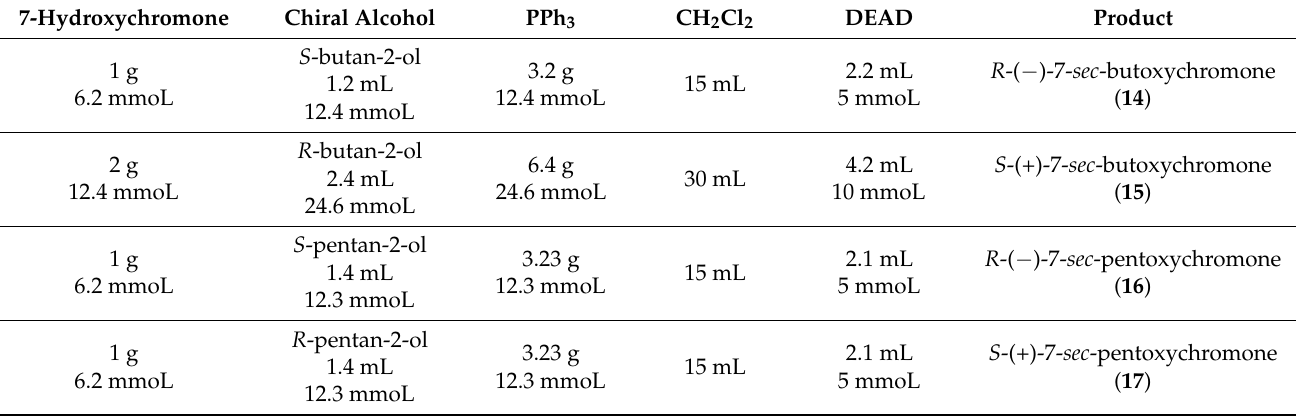
Table 2. Conditions of the synthesis of R -( − )-7- sec -butoxychromone ( 14 ), S -(+)-7- sec -butoxychromone ( 15 ), R -( − )-7- sec - pentoxychromone ( 16 ), and S -(+)-7- sec -pentoxychromone ( 17 ).